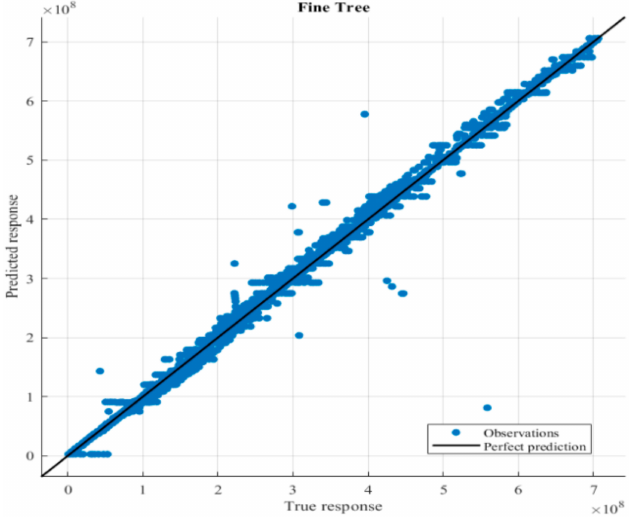
Figure 10. Fine Trees Prediction vs. Actual